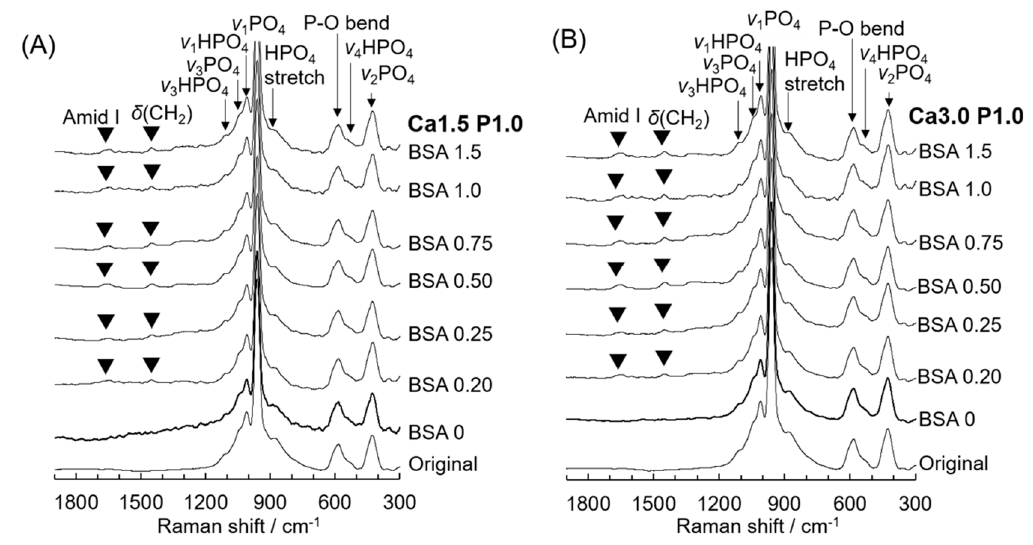
Figure 4. Raman spectra of OCP before and after incubation with 0 to 1.5 mg · mL − 1 BSA in Ca1.5P1.0 ( A ) or Ca3.0P1.0 ( B ) solutions.